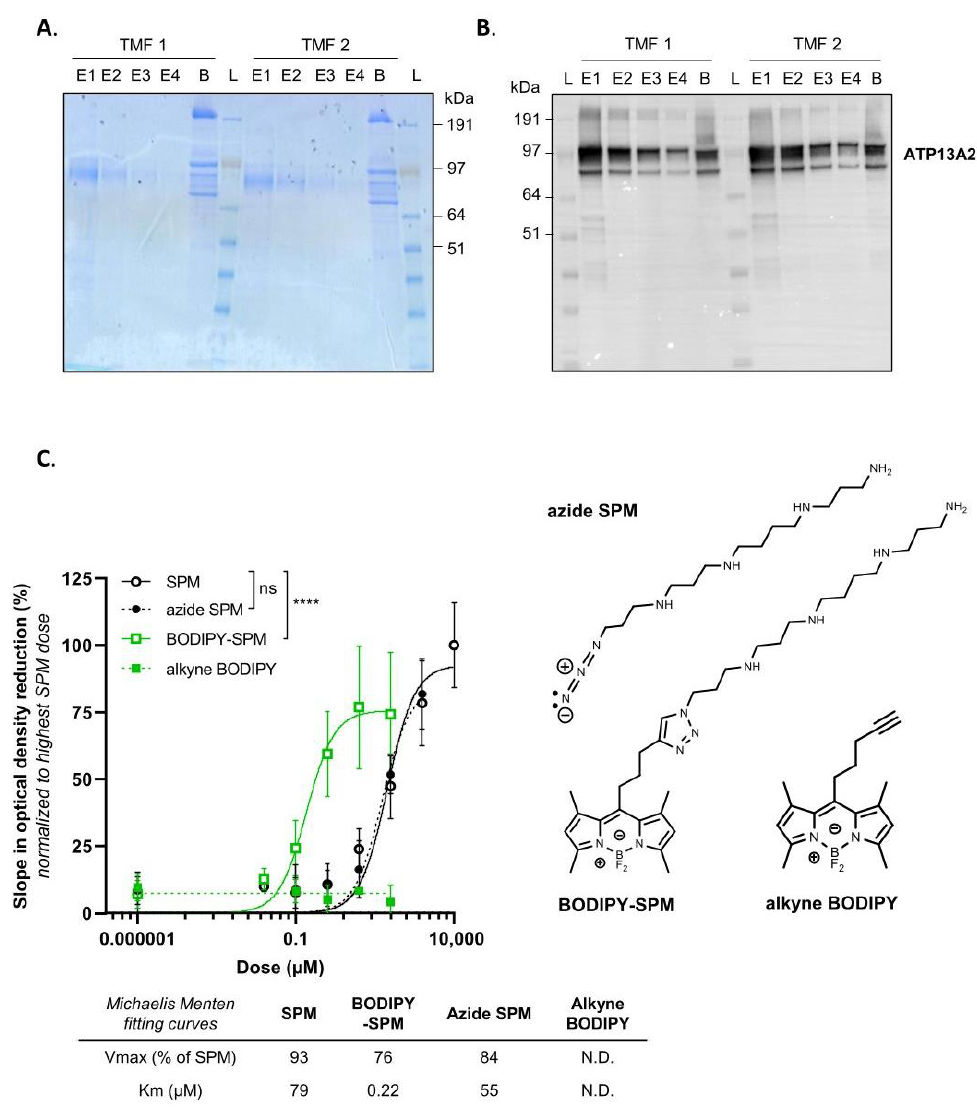
Figure 1. Purification and ATPase activity of hATP13A2. ( A ). Coomassie staining showing the purified human ATP13A2 protein present in the different elution fractions (E1 to E4) from total membrane fraction (TMF) and onto the beads (B). ( B ). Immunoblot analysis of ATP13A2 purified protein from the fractions depicted in ( A , C ). ATPase activity of purified ATP13A2 (1.25 µ g) measured with increasing concentrations of unlabeled spermine (SPM), clickable spermine (azide SPM), free BODIPY (alkyne BODIPY) and BODIPY-SPM, which structures are presented on the right (N = 2 to 7, technical duplicates, two-way ANOVA with Tukey’s multiple comparisons test; ns: not significant; ****: p < 0.001). The Y axis depicts the slope in optical density at 340 nm reflecting NADH consumption and further ATP consumption, normalized to the highest dose of SPM. V max and K m shown in the table were determined using the Michaelis–Menten fitting in GraphPad Prism software. N.D. — not determined.